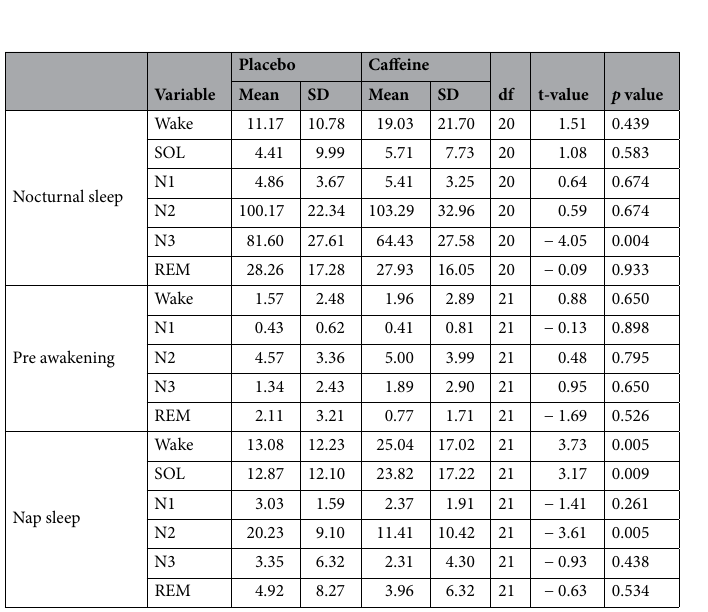
Table 1. Visually-scored sleep variables. Means and standard deviations (SD; n = 22) in min in the placebo and caffeine conditions of the nocturnal sleep episode (top), the last 10 min of nocturnal sleep (middle), and the nap sleep opportunity (bottom) are reported. SOL = sleep onset latency; N1, N2, N3, REM = NREM and REM sleep states. df = degrees of freedom. P -values refer to Benjamini–Hochberg corrected post-hoc comparisons.